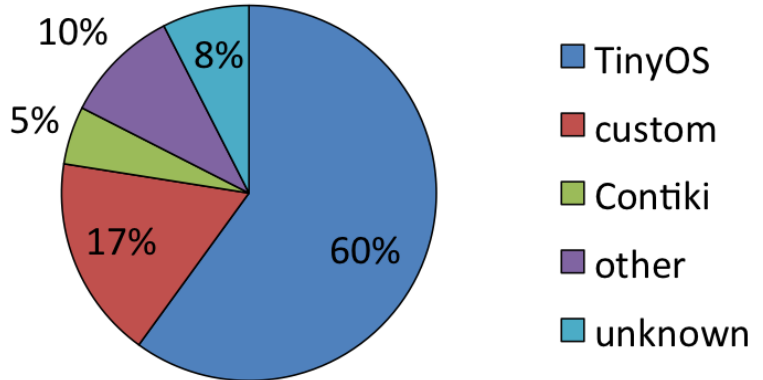
Figure 9. Operating systems used in analyzed deployments —Sixty percent of deployments use the de-facto standard: TinyOS. Seventeen percent use self-made or customized OSs.